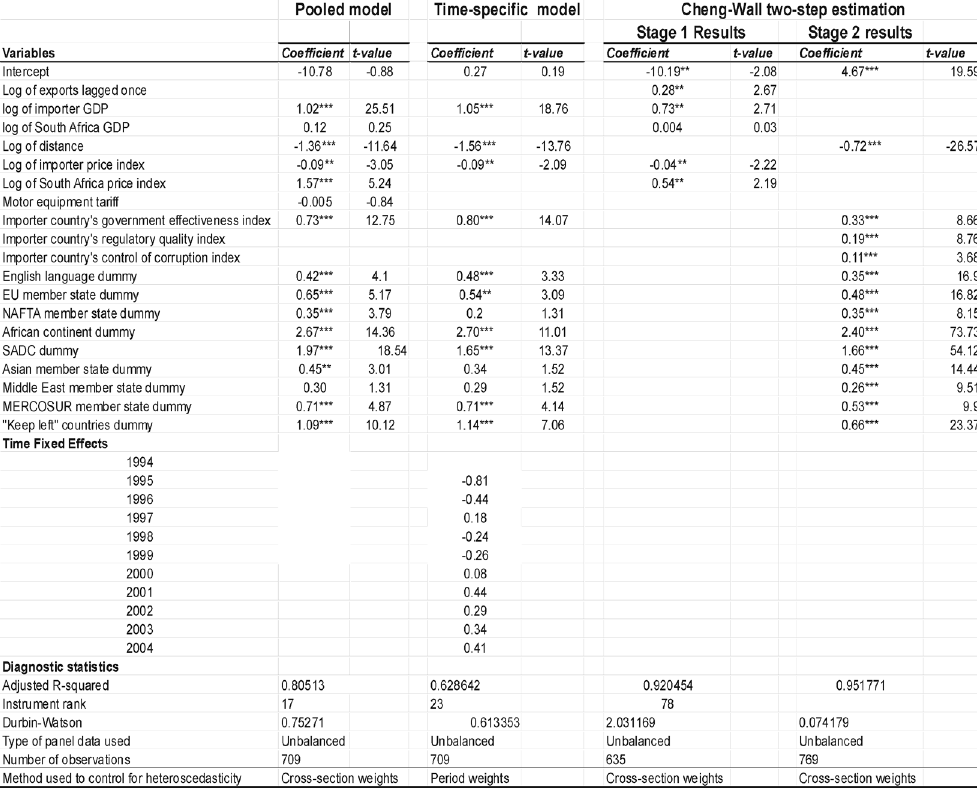
Estimation for motor vehicles, parts and accessories (SIC